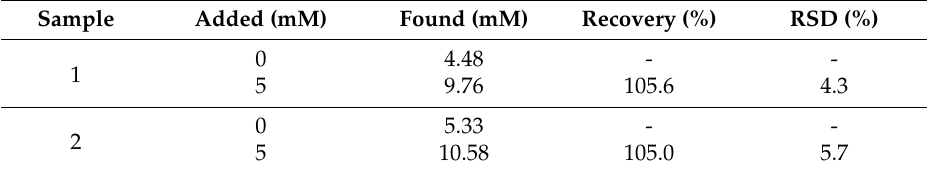
Table 1. The results of spiking recoveries of glucose in the samples of normal human serum.